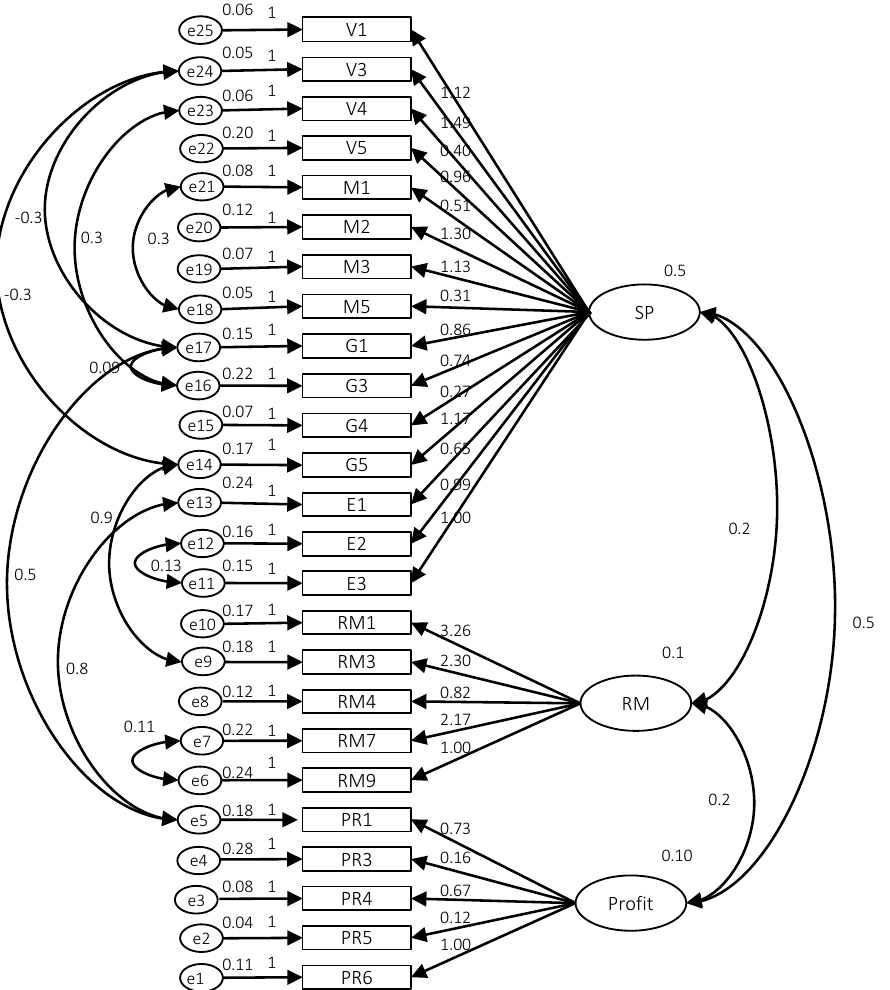
Figure 1. Measurement